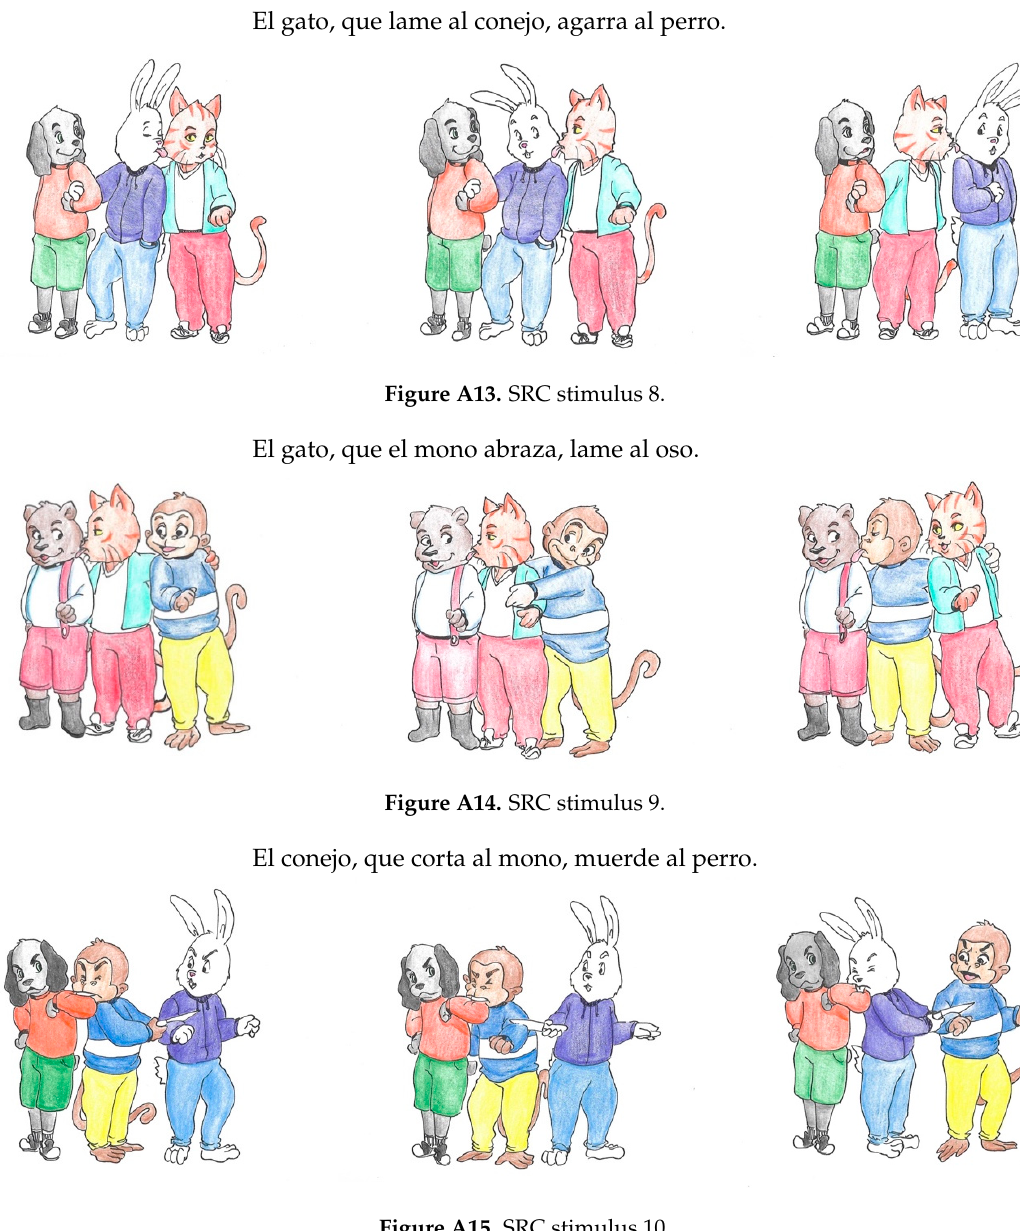
Figure A12. SRC stimulus 7.